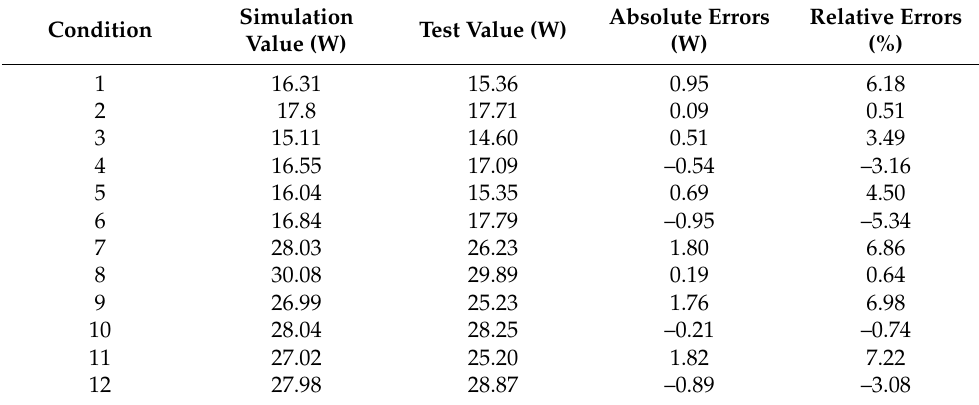
Table 8. The validation of power output.